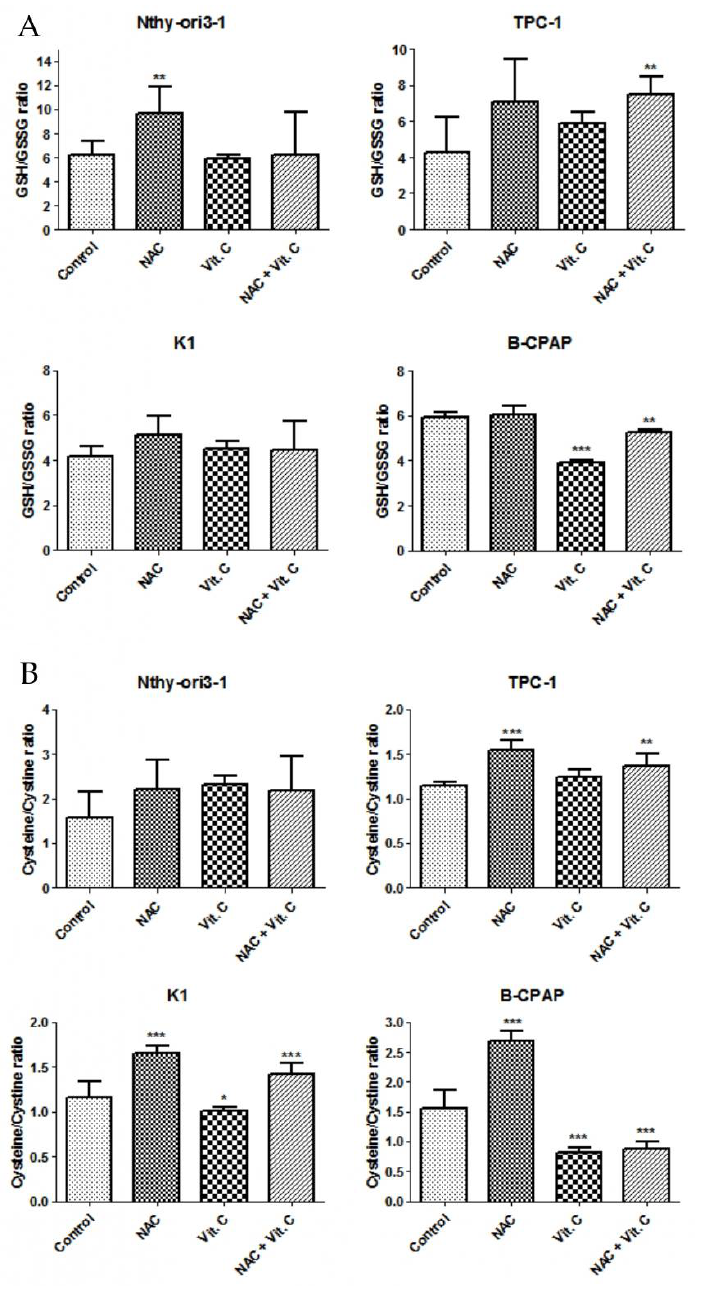
Figure 4. Levels of GSH/GSSG ratio ( A ) in PTC-derived cell lines and control cell line and levels of Cys/CySS ratio ( B ) after 24 h of incubation with vitamin C alone (5 mM) or in combination with NAC (10 mM). Peak areas of intracellular aminothiols were normalized using protein contents (ng of aminothiols per μg of proteins) and expressed as the ratio of reduced and oxidized forms. Data are expressed as Mean ± SD. All experiments were performed three times independently, each time in triplicate to confirm the results. Statistical analysis was performed by Student t-test. Re- sults were considered significant vs control when * p < 0.05, ** p < 0.01, and *** p < 0.001. 3.3. NAC Effect on Vitamin C Induced Cell Death To investigate the effect of NAC in cytotoxicity induced by vitamin C, PTC-derived and control cell lines were treated with these agents alone or in combination and cell death